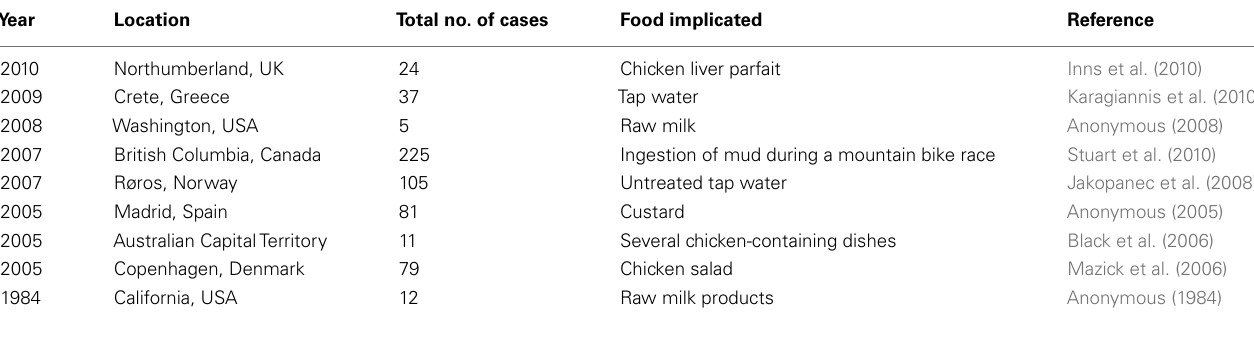
Table 2 | Food products implicated in campylobacteriosis outbreaks occurring